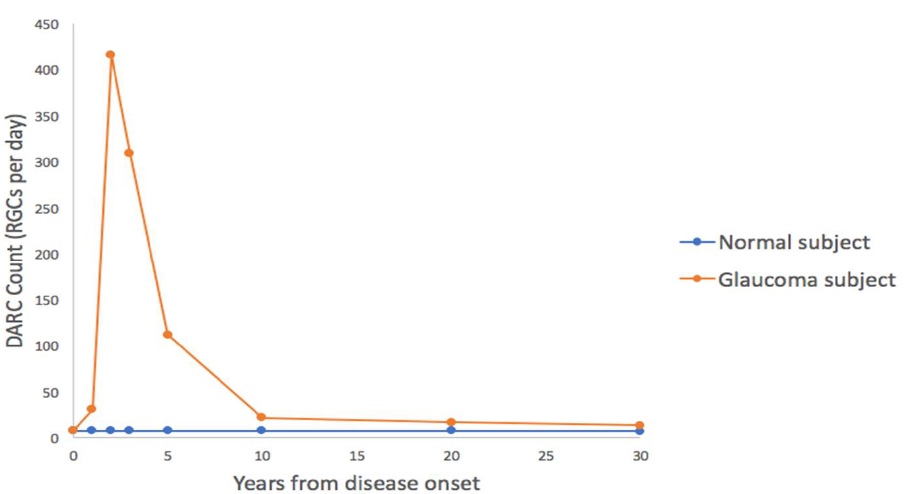
Figure 3. Lifespan-adjusted projection of DARC counts extrapolated from a rodent model of glaucoma, and superimposed onto a human disease course over 30 years. This demonstrates potential for diagnosis of early disease using DARC.